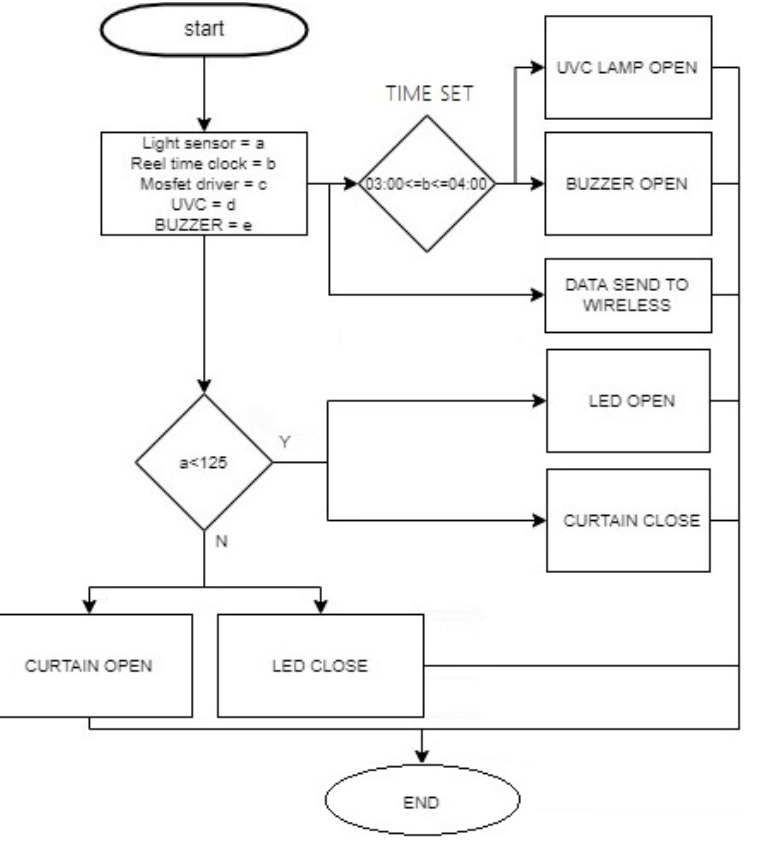
Figure 9. The basic algorithm of the software of the dynamic lighting and UVC sterilization system.